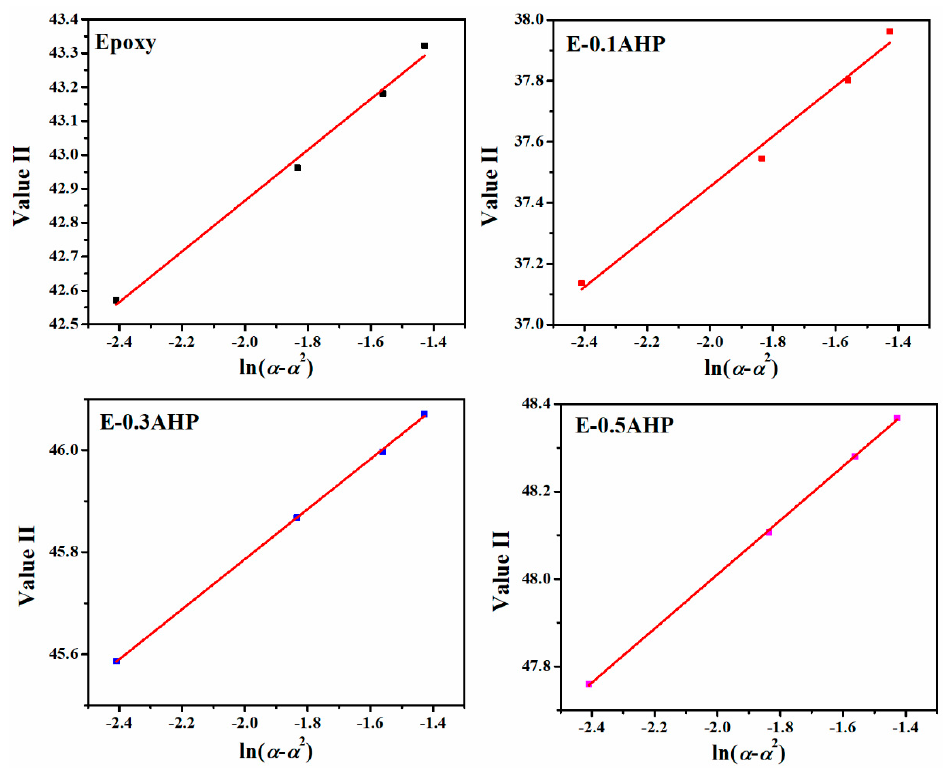
Figure A6. Plots of Value II calculated for prepared samples under heating rate of 5 °C/min.